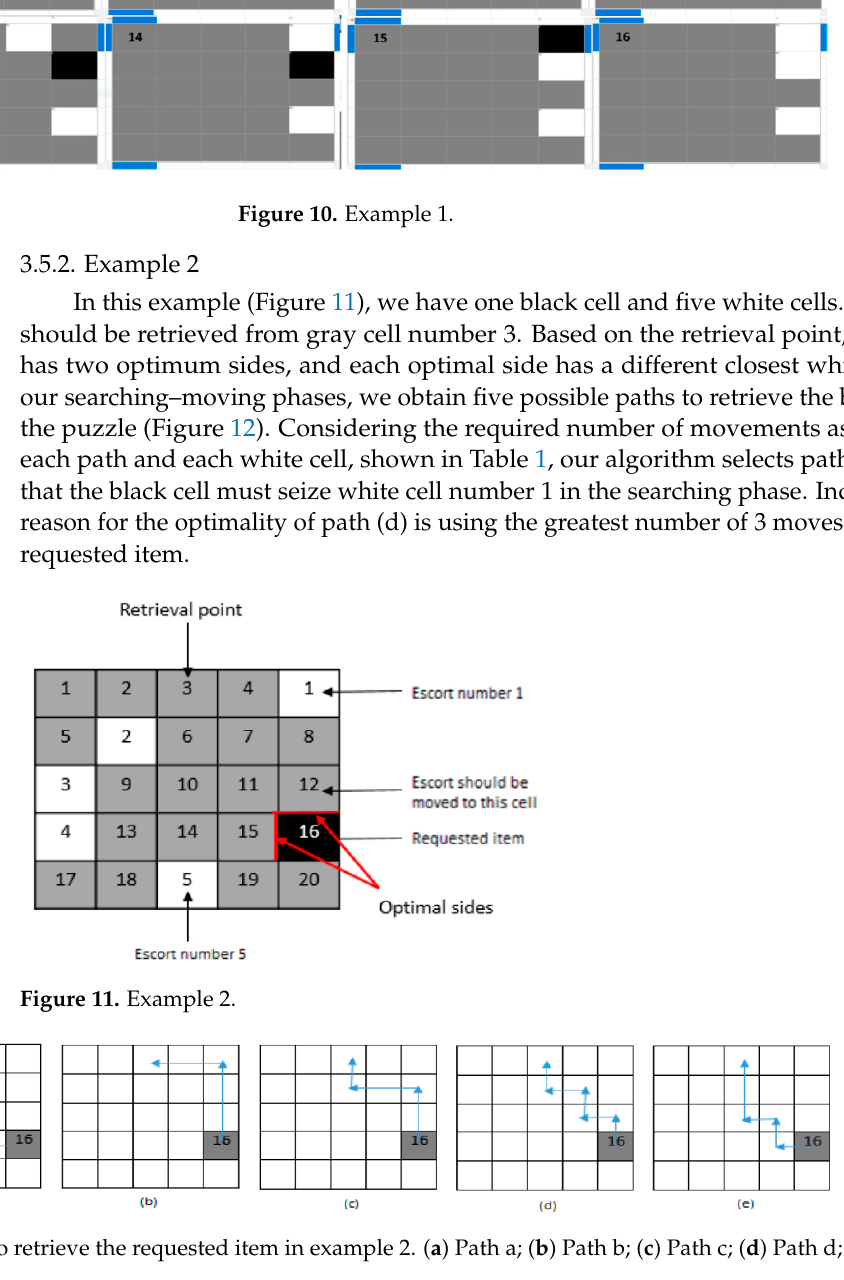
Figure 10. Example 1.